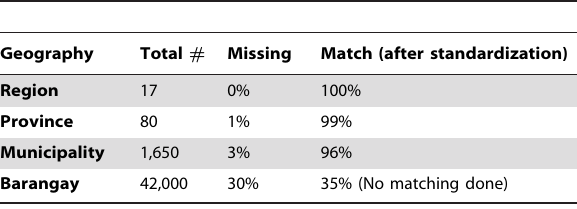
Table 3. Provinces selected for further analysis.